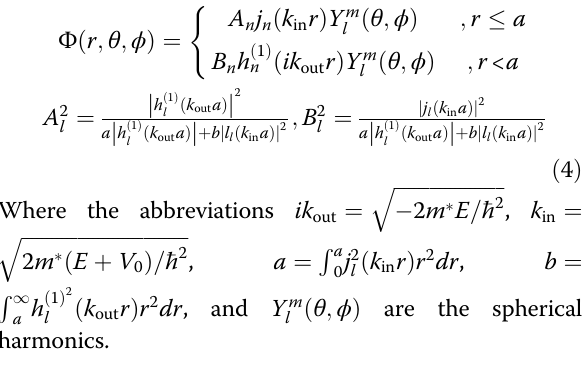
ffiffiffiffiffiffiffiffiffiffiffiffiffiffiffiffiffiffiffiffiffiffiffiffi m (cid:4) E þ V 0 ð